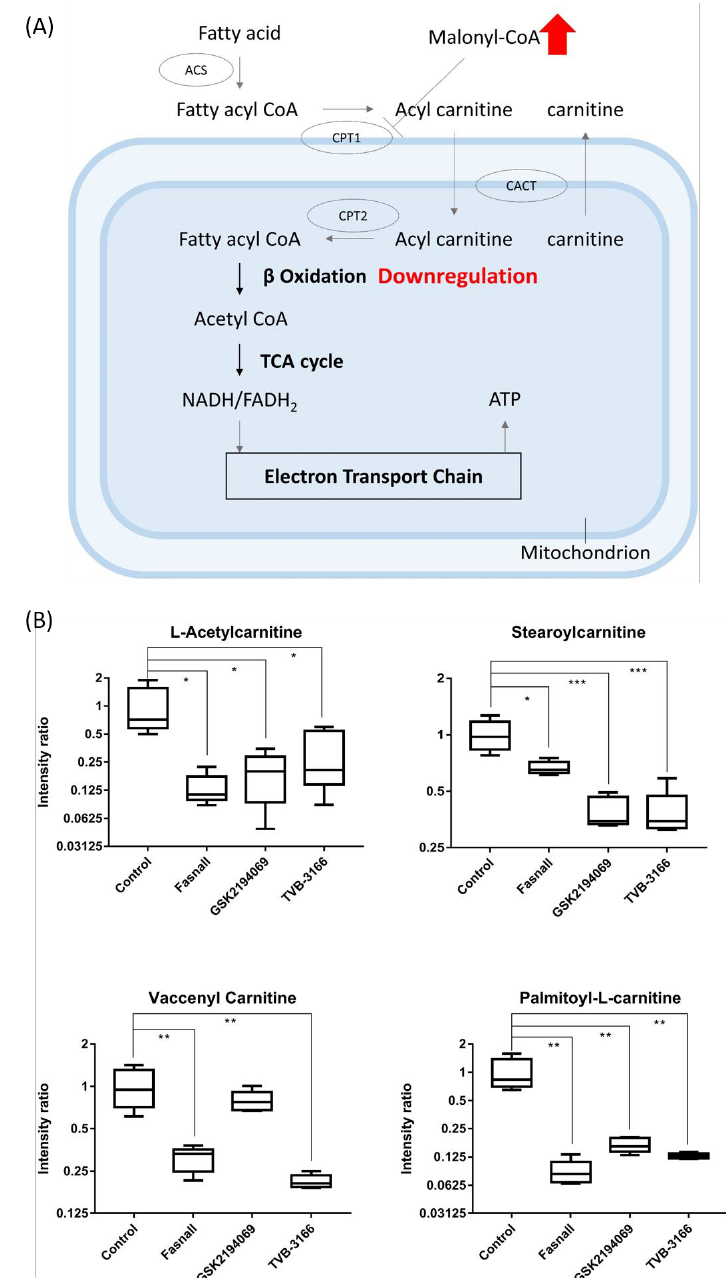
Figure 7. Carnitine box plot and beta-oxidation pathway. ( A ) Box plots showing the levels of carnitines from metabolomics data, (n = 5 per condition) *** p < 0.001, ** p < 0.01, * p < 0.05, Student’s t -test. ( B ) The metabolic pathway of fatty acid oxidation in which CPT-1 can be inhibited directly by malonyl-CoA, a crucial intermediate in FAS.